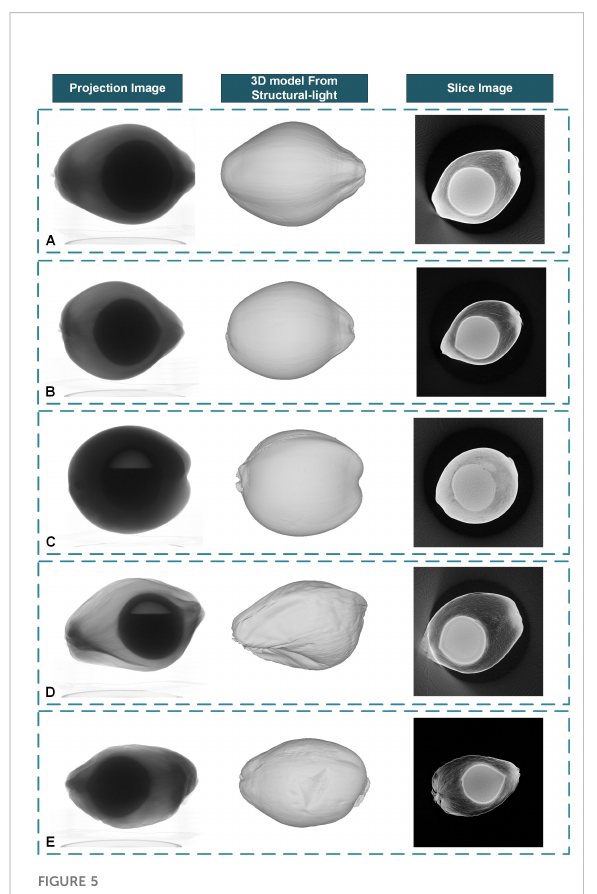
FIGURE 5 The coconut fruit projection images from the Micro-CT system, the corresponding 3D model from the structured light system, and the reconstructed slice images with some out-of-ranged samples. (A) An out-of-ranged immature sample with full liquid albumen. (B) A normal immature sample with full liquid albumen. (C) A normal immature sample with limited liquid albumen. (D) An out-of-ranged mature sample with limited liquid albumen. (E) A normal mature sample with full liquid albumen.